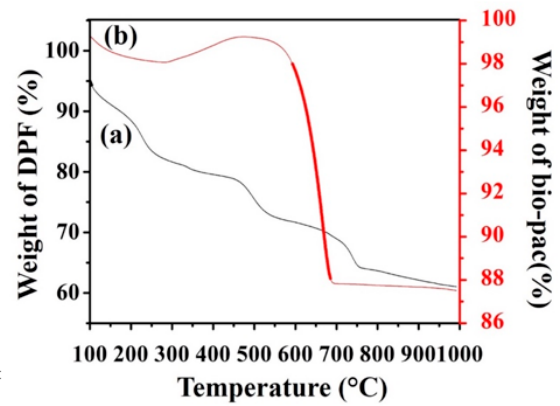
Figure 5. Thermogravimetric analysis (TGA) curves for ( a ) raw date palm fibre (DPF) before activation ( b ) bio-powder activated carbon (bio-PAC) after activation.